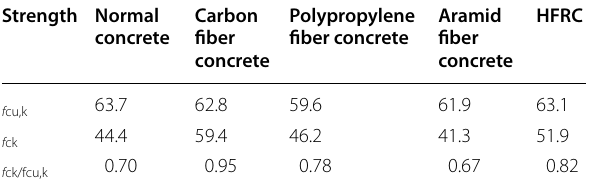
Table 7 Peak stress and cubic compressive strength.